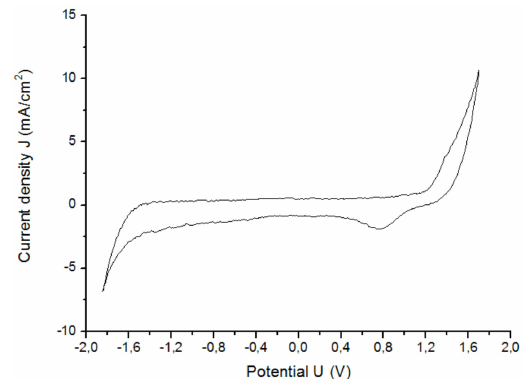
Figure 18. CV of the graphene electrode F in NaCl solution.(scan rate = 100 mV, scan number =